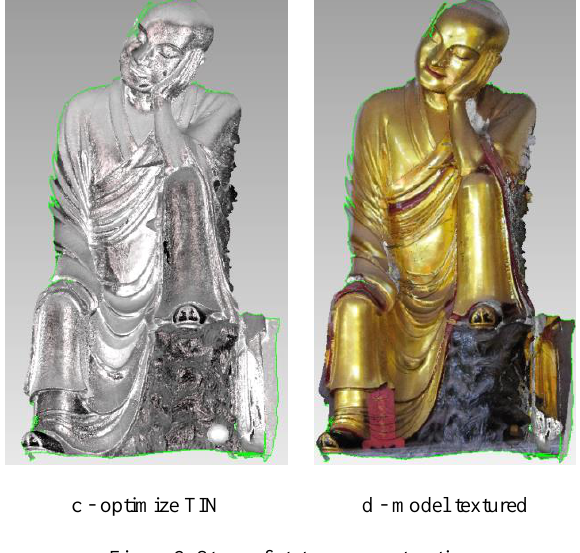
Figure 2. Steps of statues